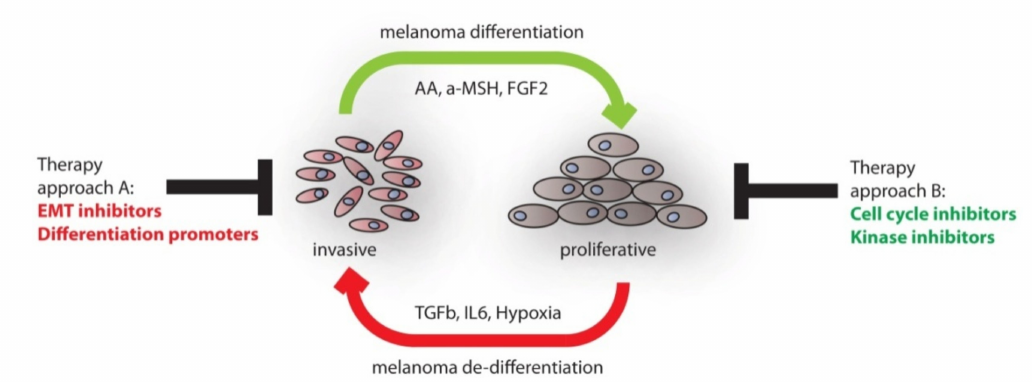
Figure 2. Dynamic process of phenotype switching in human melanoma. Proliferative melanoma cells become invasive and migrative upon stimulation with extrinsic factors. In turn, invasive melanoma cells switch to a more di ff erentiated and proliferative phenotype when treated with ascorbic acid (AA), the hormone a-MSH or the growth factor FGF-2. Therapeutic options include ( A ) treatment of invasive cells with epithelial mesenchymal transition (EMT) inhibitors or di ff erentiation promoters and ( B ) treatment of proliferative cells with cell cycle or kinase inhibitors. Importantly, therapy should stop the continuous switching between cellular states. AA: Ascorbic Acid, a-MSH: α -Melanocyte stimulating hormone, FGF2: basic fibroblast growth factor, TGFb: transforming growth factor beta, IL6: interleukine